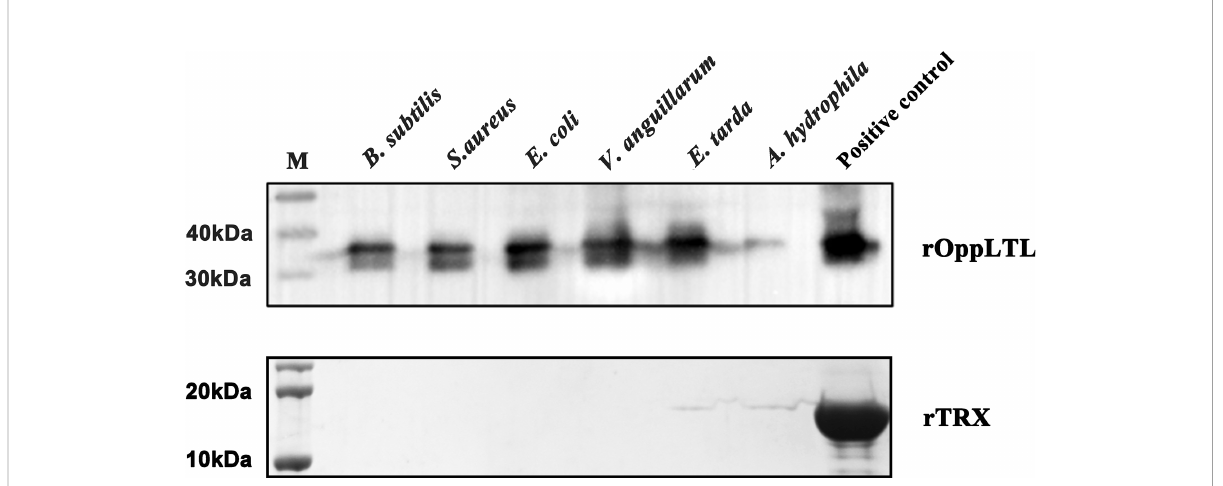
FIGURE 6 Binding activity of rOppCTL to microorganisms. Lane M: pre-stained marker (kDa); lane 1: B subtilis ; lane 2: S. aureus ; lane 3: E coli ; lane 4: A hydrophila ; lane 5: V. anguillarum ; lane 6: E tarda ; lane 7: rOppLTL/rTRX as positive control. The binding activity of rTRX protein was tested and used as the negative